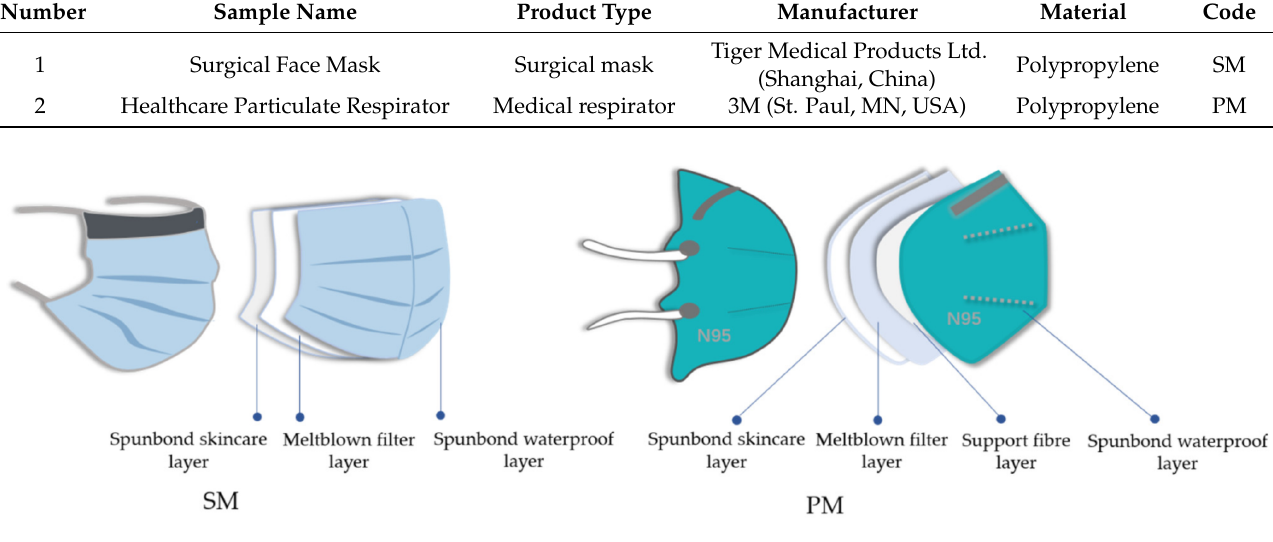
Figure 1. Schematic diagram representing the whole multilayer structure of the masks.